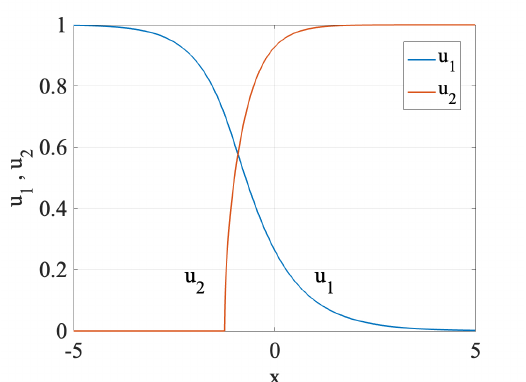
Figure 4. An example of the asymmetric DW, as given by Equations (65)–(68), for D = 1 and G = 2 (here, u 1 and u 2 stand for r 1 and r 2 in the analytical solution). Note that the coordinate of the stitch point is, in this case, x 0 ≈ − 1.25 as per Equation (65), and the “virtual center” of the bright-soliton segment of u 1 ( x ) is located at ξ ≈ − 1.80 as per Equation